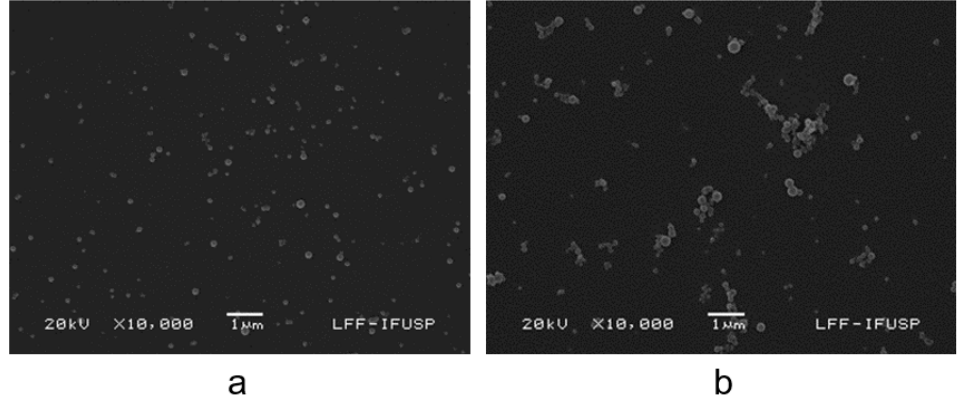
Figure 1. Scanning electron micrographs of gramicidin (Gr) dispersions at 0.05 mM Gr in pure water ( a ) or in 0.05 mg/mL poly (diallyldimethyl ammonium chloride) (PDDA) solution ( b ).